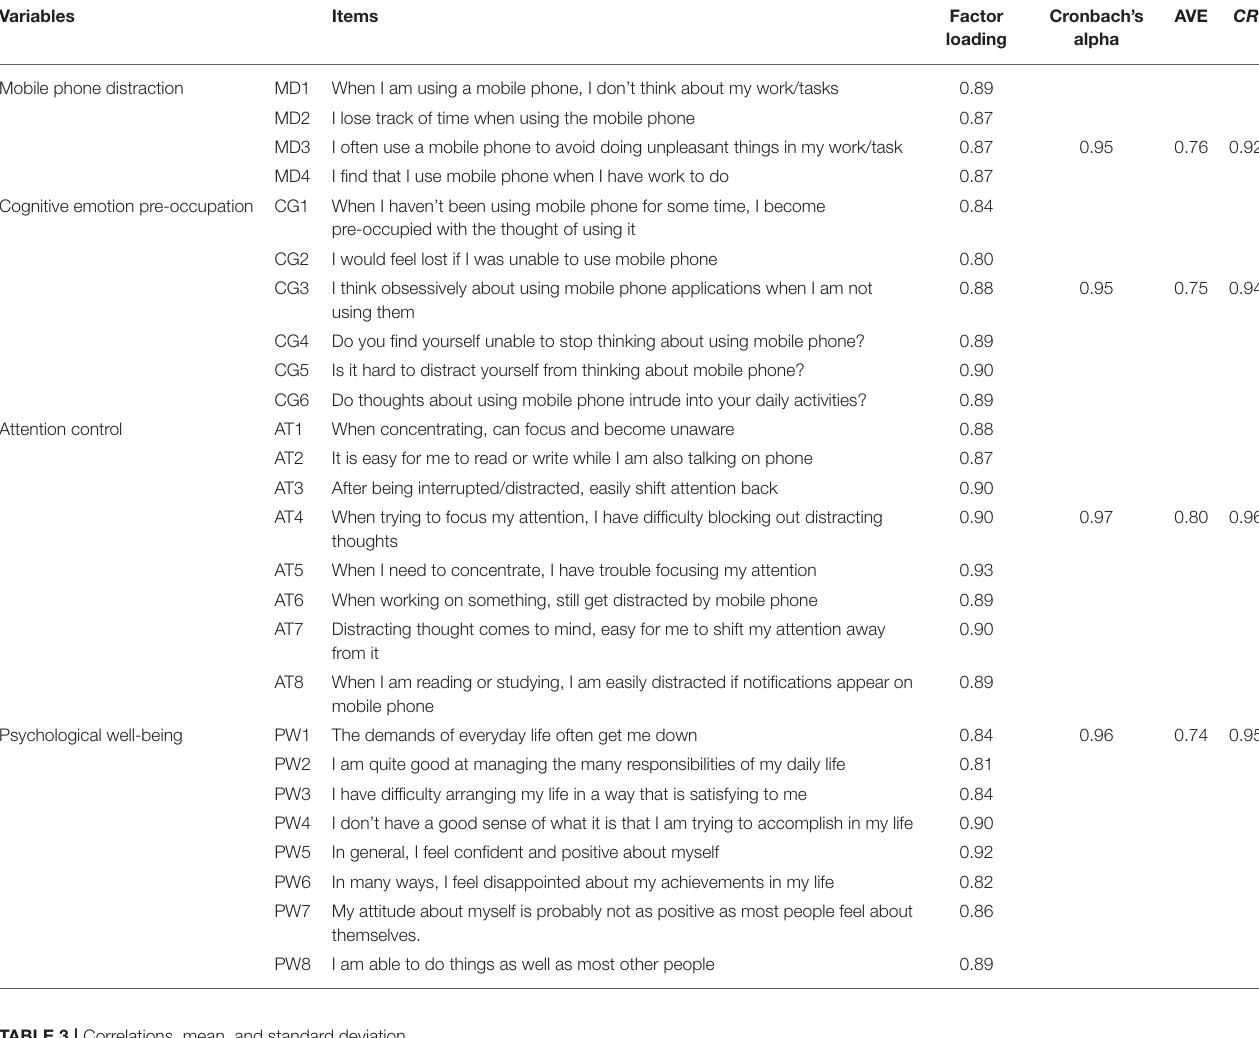
TABLE 2 | Confirmatory factor analysis, AVE and composite reliability. Variables Items